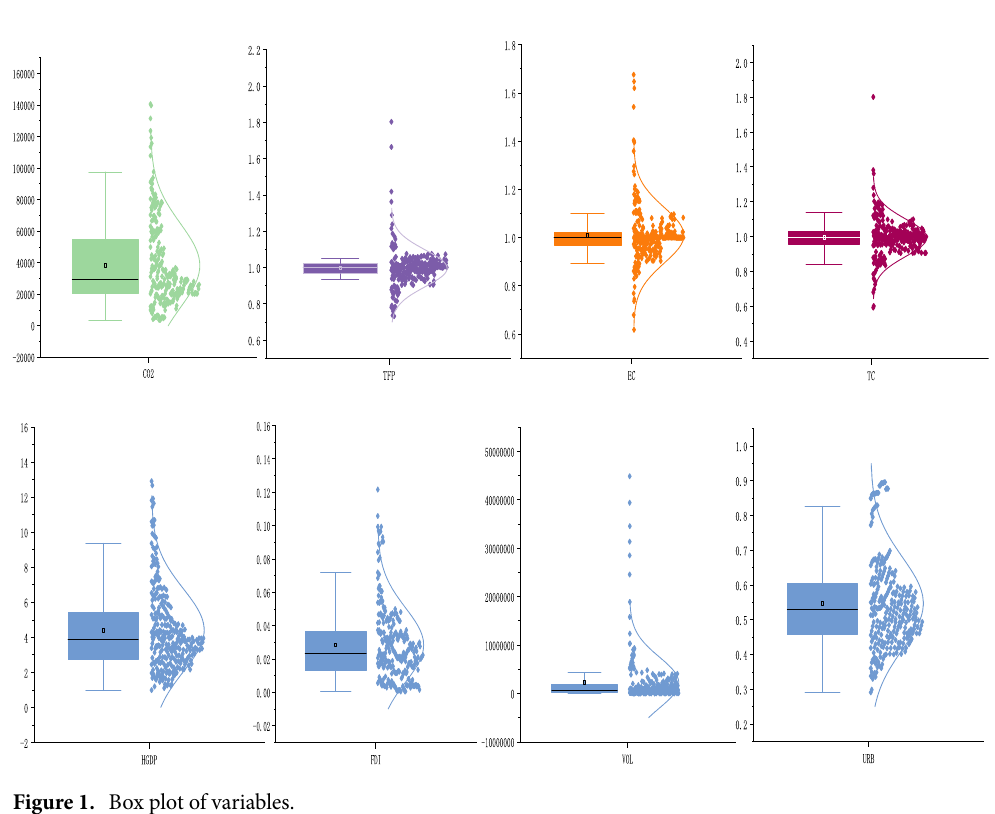
Figure 1. Box plot of